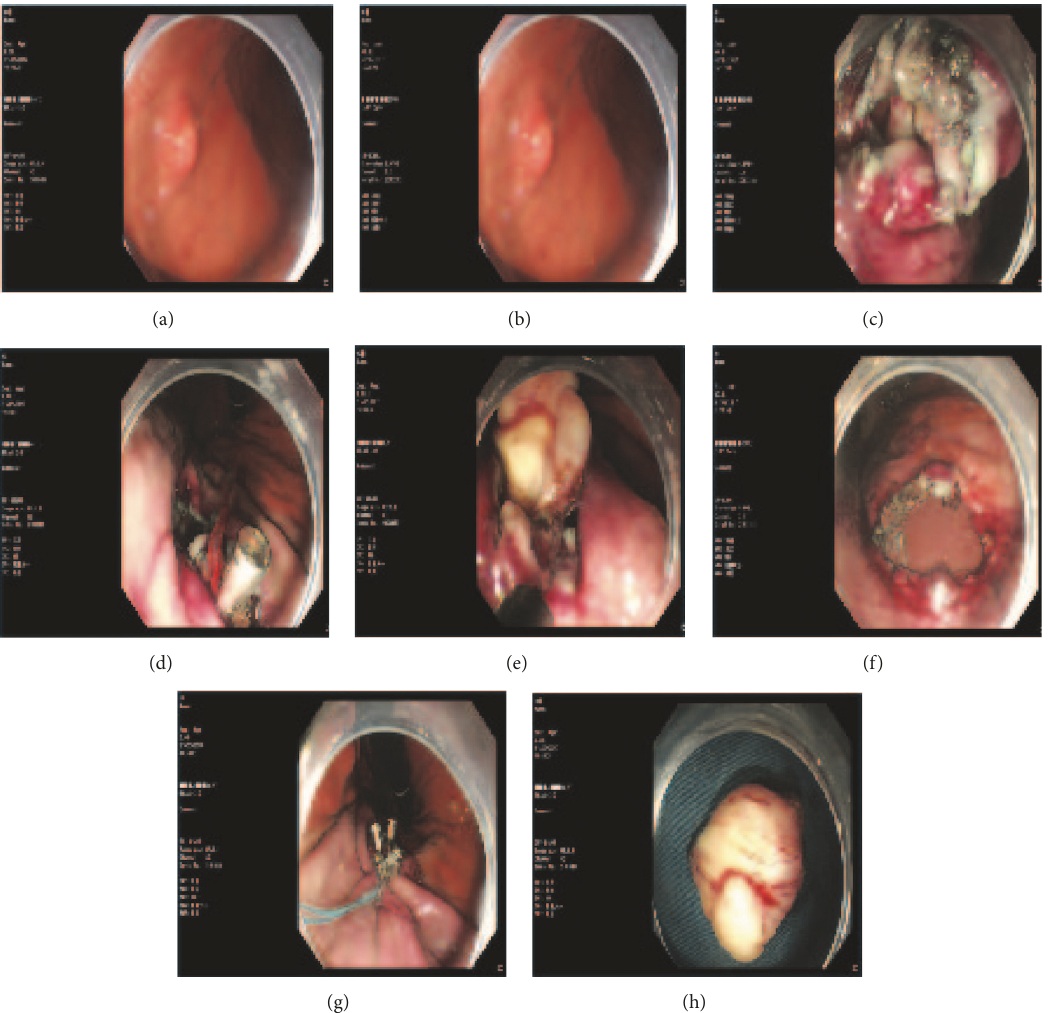
Figure 1: ESD with dental floss clip traction. (a) A bump was seen in the anterior gastric corpus wall (endoscopic ultrasound showed it originated from the muscular layer and grows extraluminally, 2.0cm in diameter), labeled with Hook Knife. (b) The mass was showed after Hook knife precutting the mucous layer. (c) Strip off the mass. (d) The mass was pulled by the dental floss clip. (e) The lesion clearly exposed with the dental floss traction. The lesion was easier to remove en bloc with hook knife. (f) The post-ESD wound has no defect left. A large perforation was seen. (g) The wound was large and closed with nylon loop pouch-suture through a single channel endoscope. (h) The